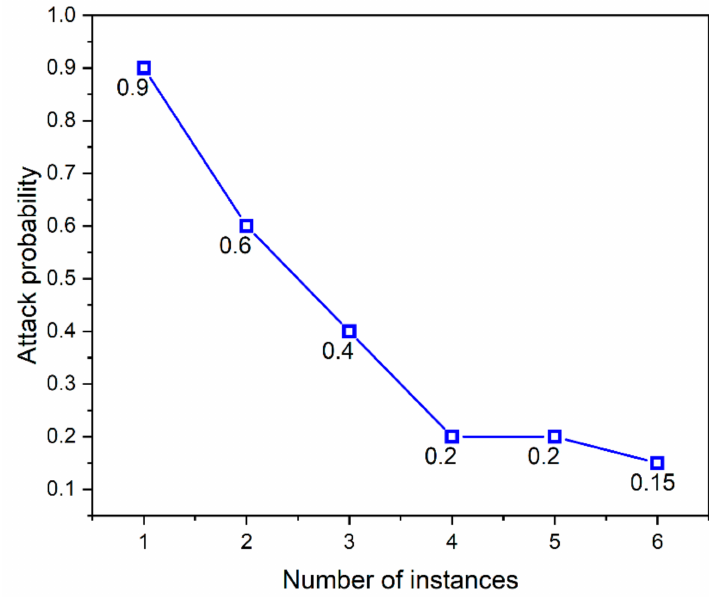
Figure 11. Attack probability on